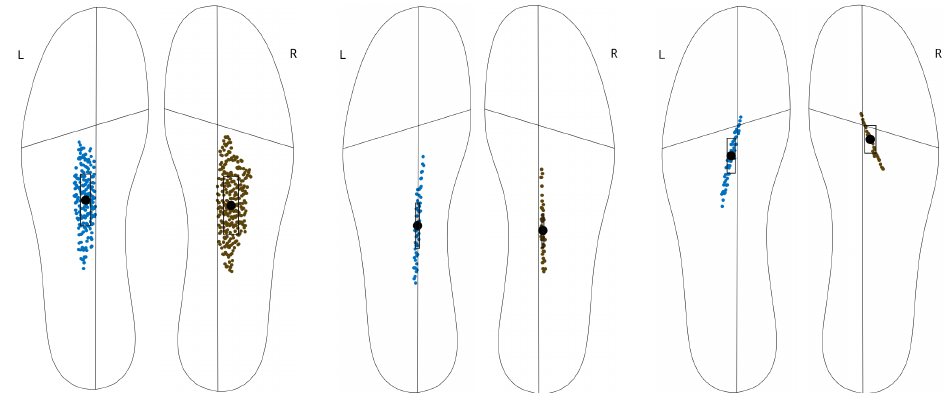
Figure 2. Center of Pressure recording of different single leg balancing tasks. We recorded both legs individually using Moticon Pressure Insoles. Left: Single leg balancing on regular surface. The CoP is moving in the anterior-posterior and in medial-lateral direction. Middle: Balancing on the slackline with aligned stance foot. Right: Balancing on the slackline with turned stance foot. The CoP is constrained by the direction of the slackline and to a single